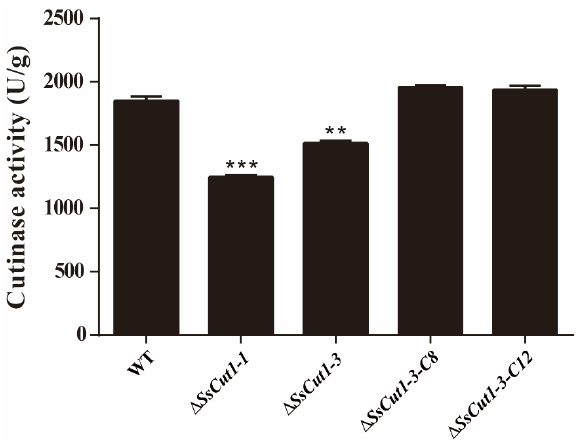
Figure 6. Cutinase activity of wild-type strain and SsCut1 transformants. All strains were cultured on PDA medium. The hyphal of wild-type strain and SsCut1 transformants was collected at 36 hpi. Cutinase activity levels were examined with the enzyme-linked immunosorbent assay (ELISA) method. Bars indicate ± SE. Statistical significance is indicated in the graph (one-way ANOVA): ** p < 0.01, *** p < 0.001.